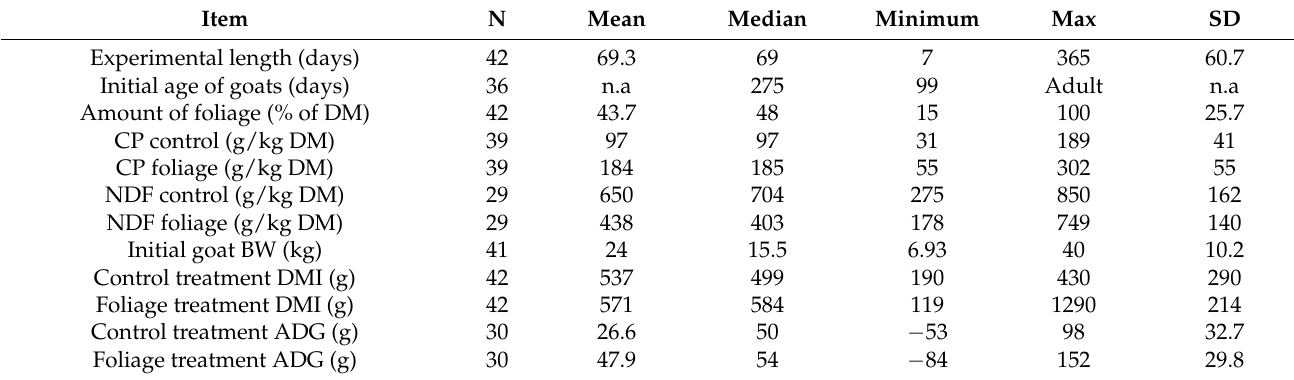
Table 1. Selected characteristics of the 42 papers describing 117 experimental treatments included in the meta-analysis. Publication year between 1990 and 2016, median